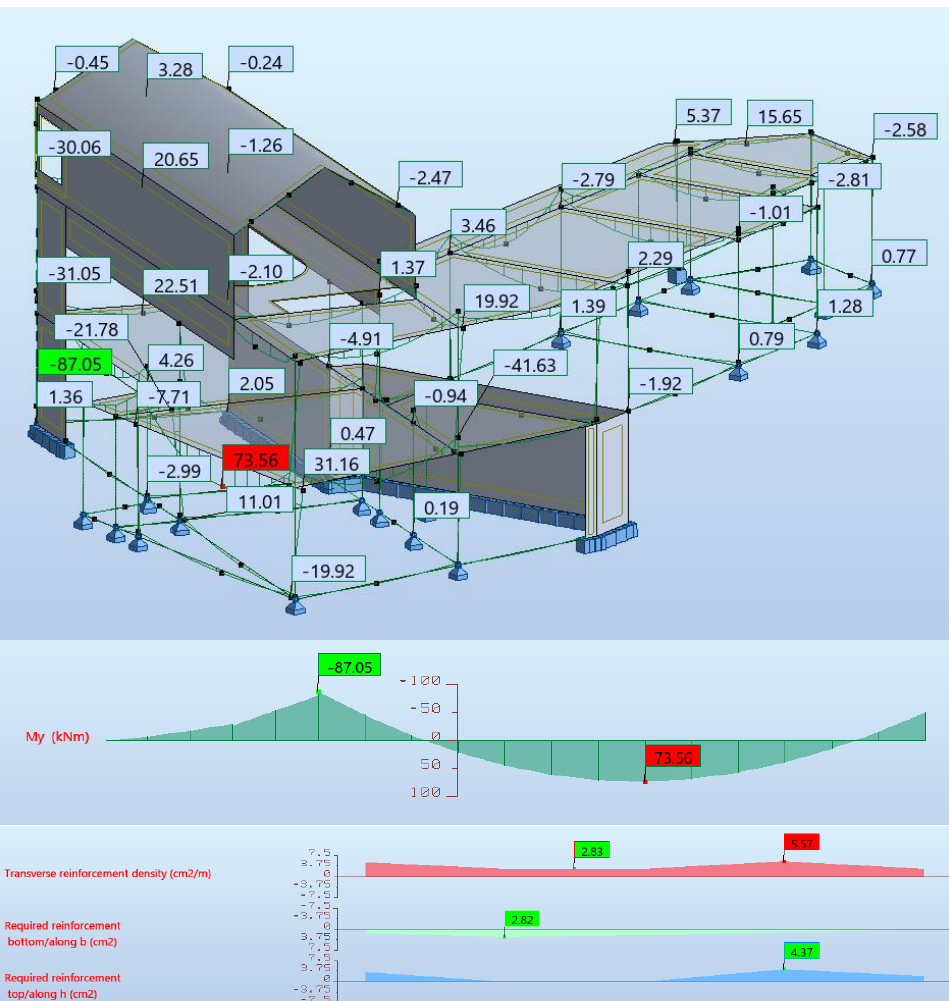
Figure 9. Individual analysis of the beam of alignment A and My moment and required reinforcement areas.